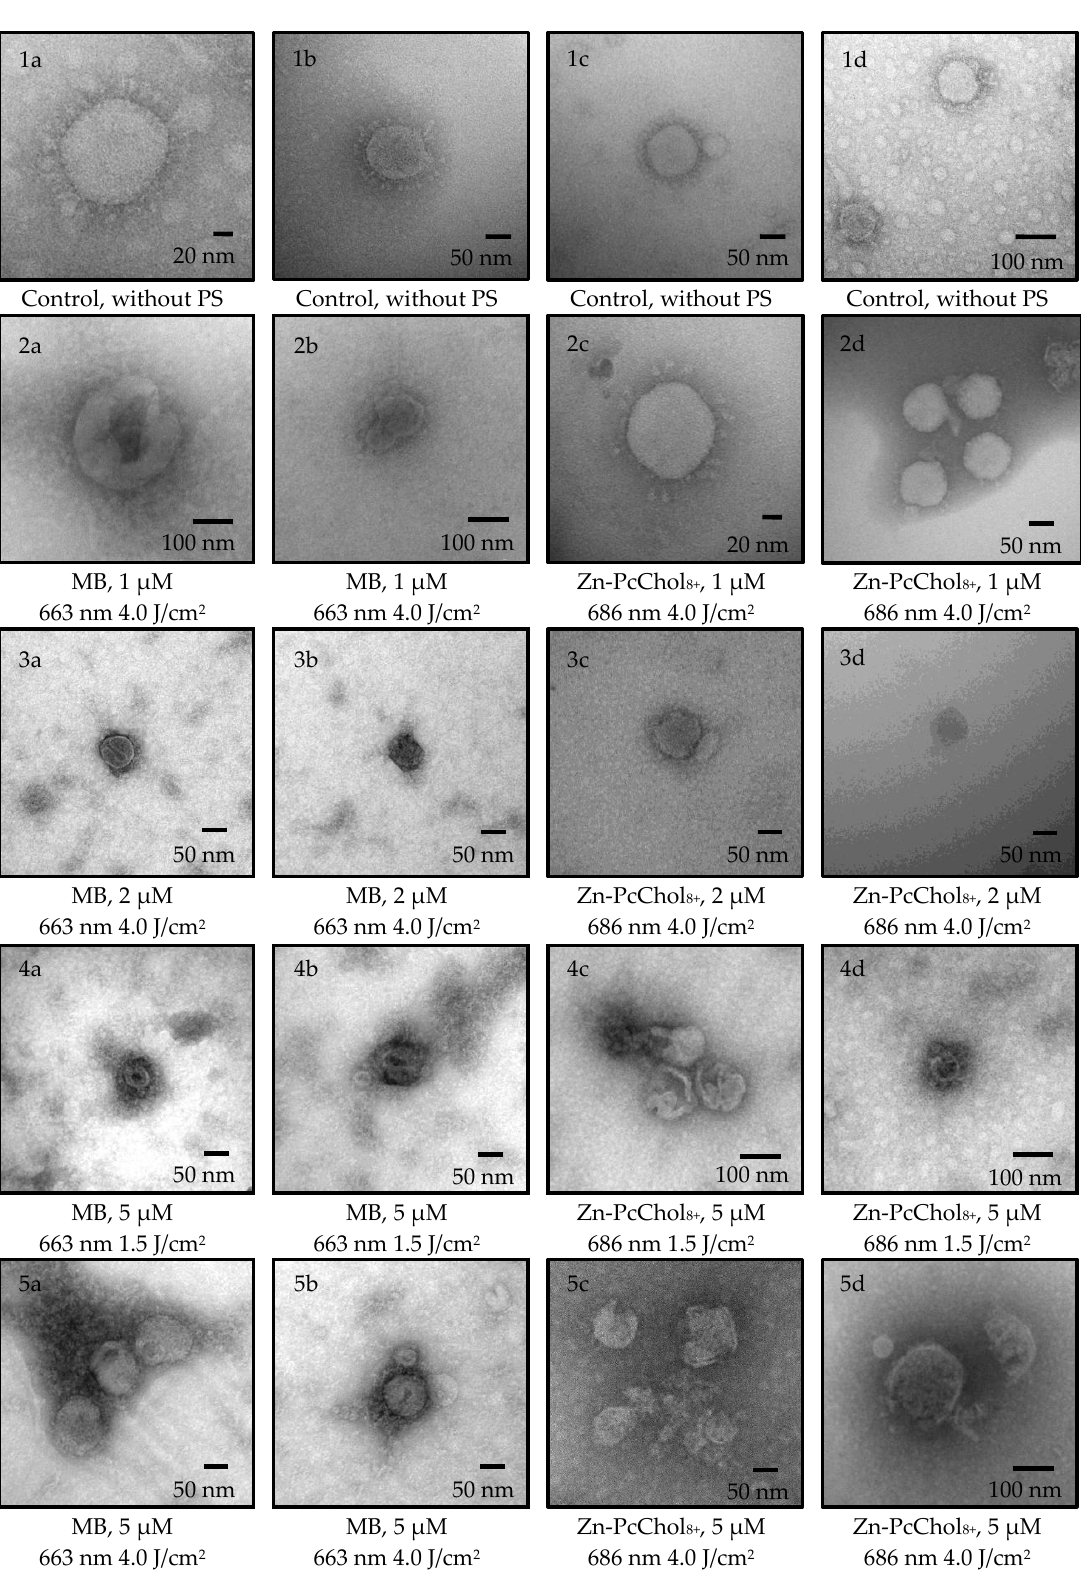
Figure 4. Electron micrographs of control BCoV, negatively stained with 2% uranyl acetate from Figure 2 ( 1a – 1d ). BCoV incubated at 10 min with 1 µ M ( 2a – 2d ), 2 µ M ( 3a – 3d ), or 5 µ M ( 4a – 4d , 5a – 5d ) of MB or Zn-PcChol 8+ , and irradiated with LED 663 nm for MB or 686 nm for Zn-PcChol 8+ . Light doses were 1.5 J/cm 2 ( 4a – 4d ) or 4.0 J/cm 2 ( 2a – 2d , 3a – 3d , 5a – 5d